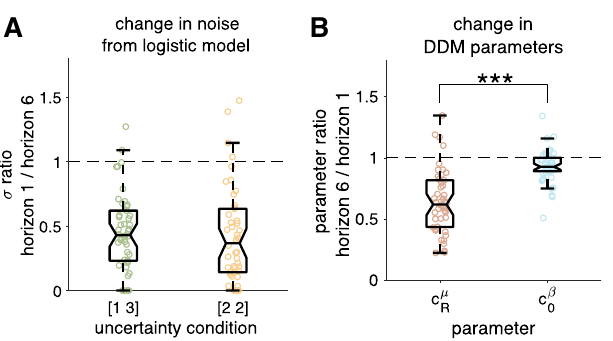
Figure 8. Sensitivity analysis. ( A ) The ratio of decision noise in horizon 6 compared to decision noise in horizon 1 computed using the σ parameter from the logistic model for the equal and unequal conditions. In both cases the median ratio is just over 2. ( B ) The ratios of drift-diffusion parameters, c those in horizon 6. Note that for comparison with panel ( A ), the ratios are reversed (i.e. horizon 1:horizon 6 for ( B ) instead of horizon 6:horizon 1 for ( A ), see Eq. 18). *** indicates a significant difference at p < 0.001